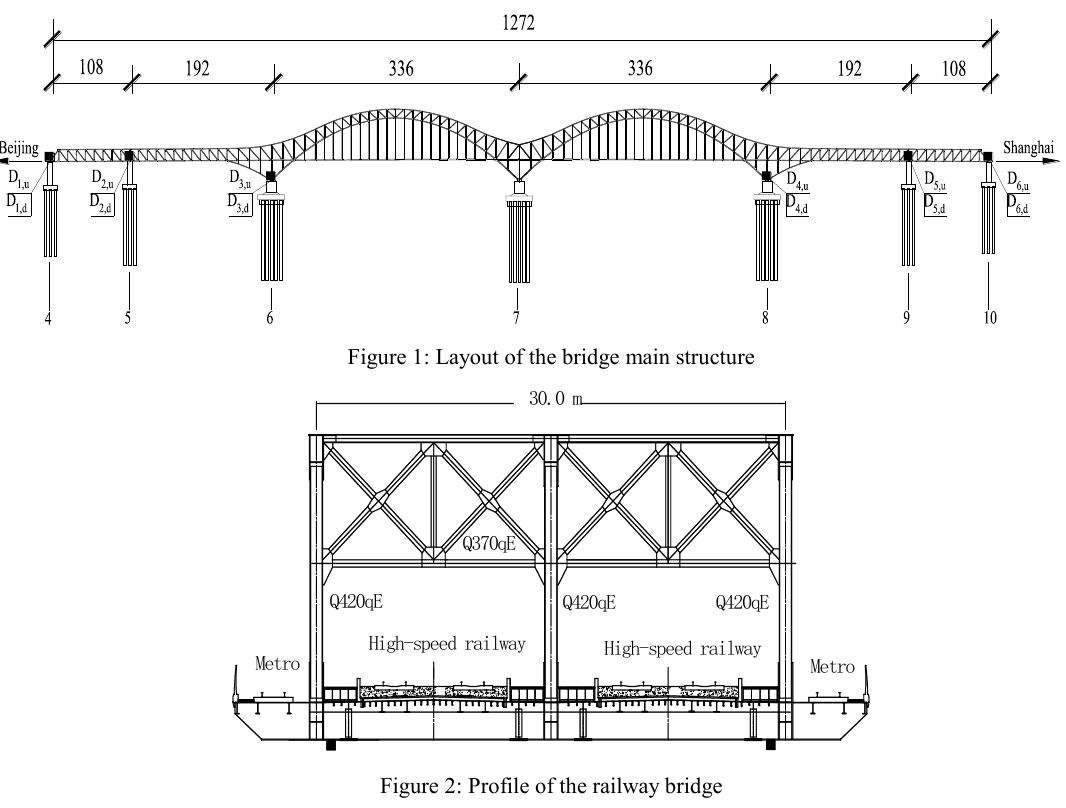
Figure 2: Profile of the railway